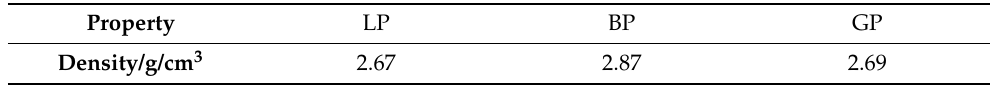
Table 2. Relative densities of mineral powders.